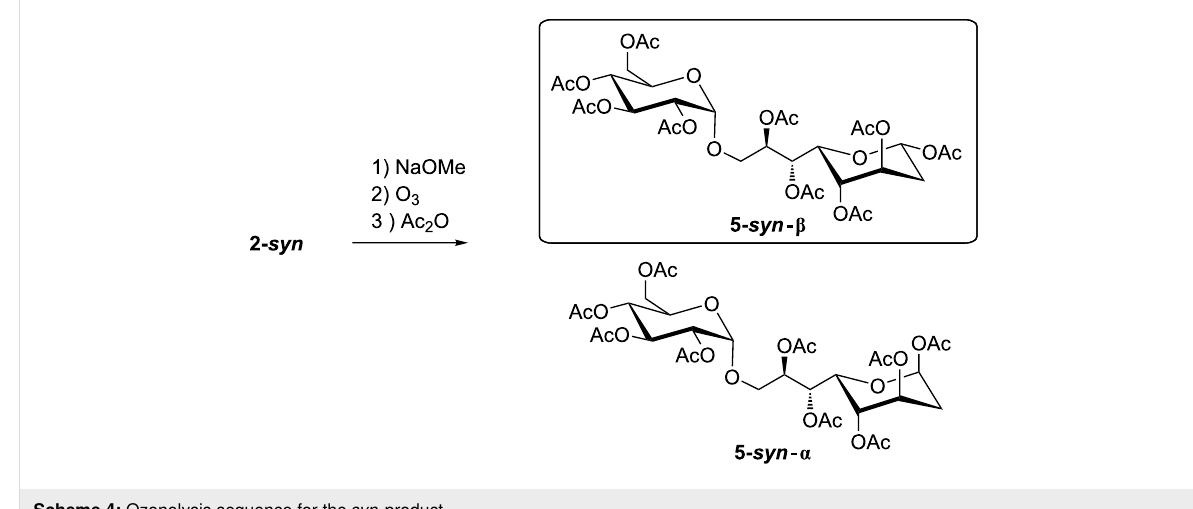
Scheme 4: Ozonolysis sequence for the syn -product.